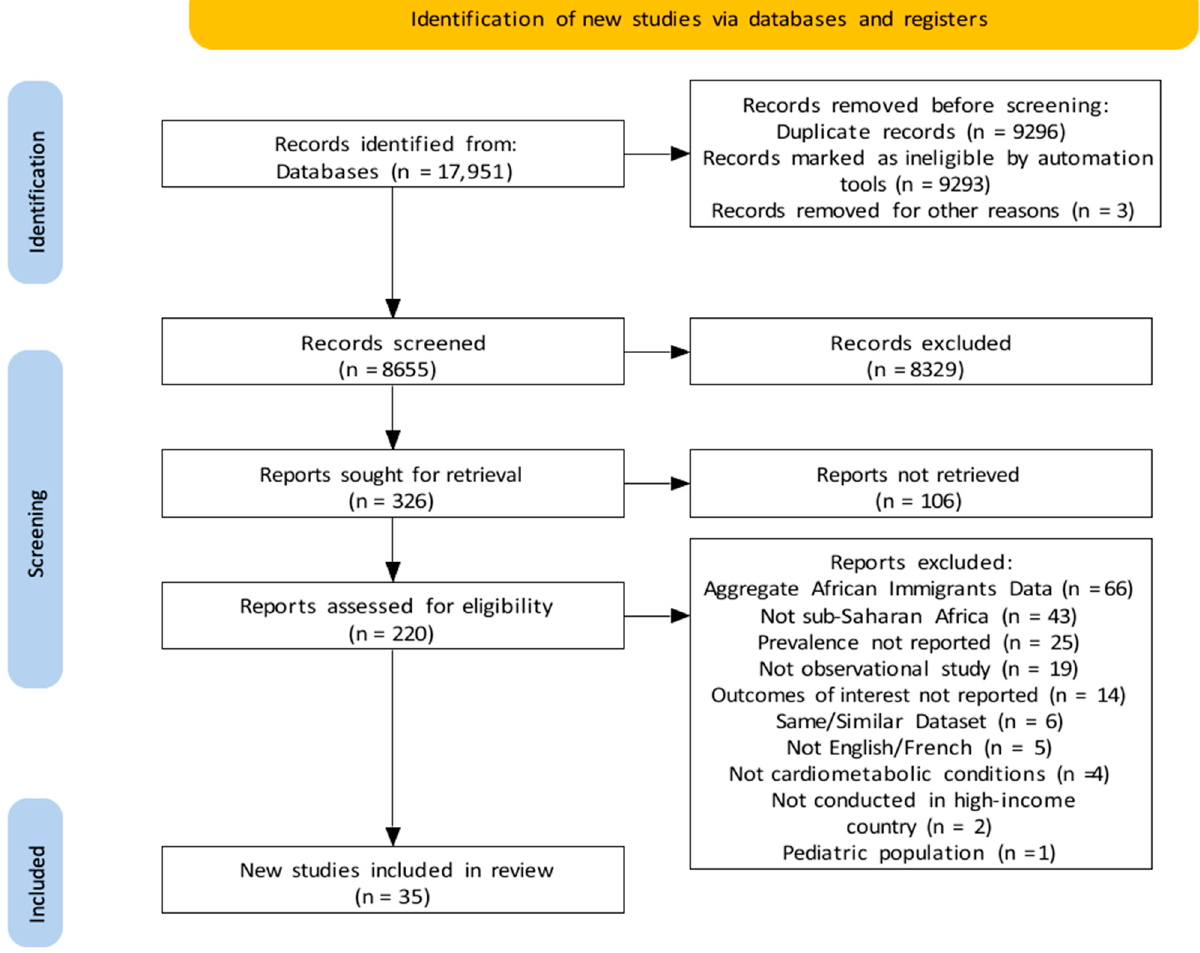
Figure 1. PRISMA flow diagram showing literature search and article inclusion